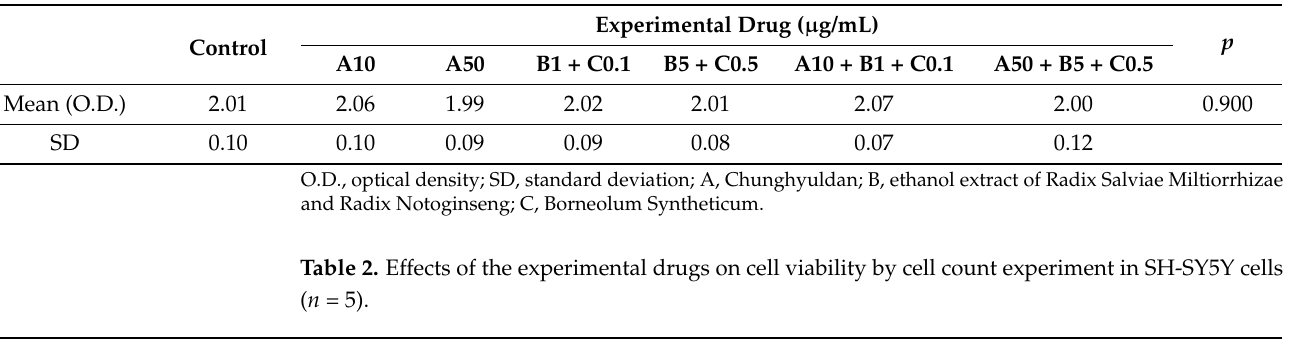
Figure 2. HPLC chromatogram of ginsenoside Rg1 and Rb1. ( a ) Standard mixture of ginsenoside Rg1 and Rb1. ( b ) Cardiotonic pills contained 0.36% of ginsenoside Rg1 and 0.34% of Rb1. ( c ) Sample B contained 0.83% of ginsenoside Rg1 and 0.95% of Rb1.